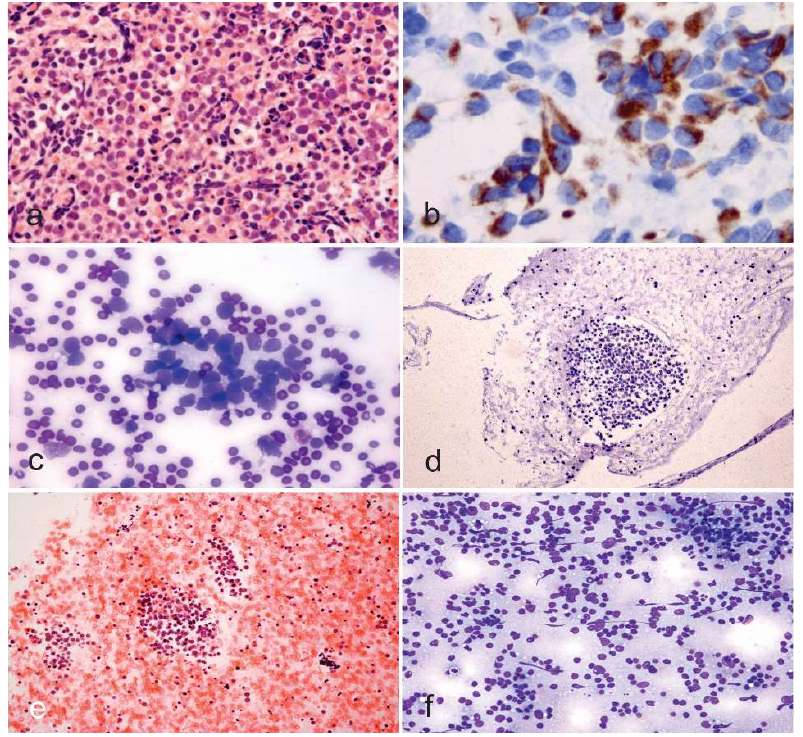
Figure 1. ( a , b ) Rhabdomyosarcoma cytology in cell block (Papanicolaou, ×200) and smears fixed and immunostained with the antibody anti-desmin (Avidin-Biotin-Complex immunostaining, ×630). ( c , d ) Neuroblastoma cytology in smears and cell block showing hyperchromatic cells with high nucleus to cytoplasm ratio (Diff-Quik, ×100 and ×100, c and d , respectively). ( e , f ) Reactive changes of soft tissue showing a mixture of cells with variable morphology (cell block and smears stained with Papanicolaou and Diff-Quik, ×100 and ×100, e and f , respectively).